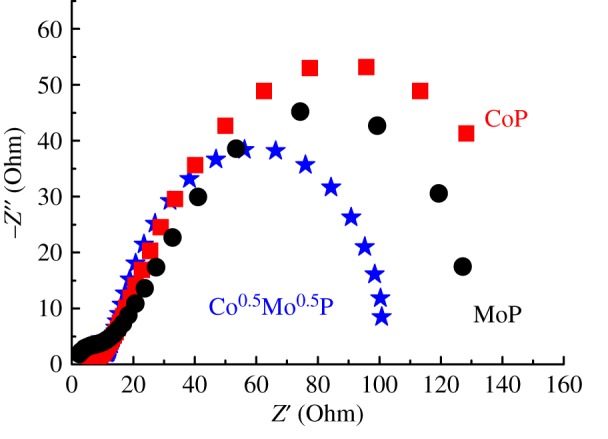
Comparison of the Nyquist plots of the Co0.5Mo0.5P, CoP and MoP catalysts at an overpotential of 100 mV in 0.1 M HClO4 solution.